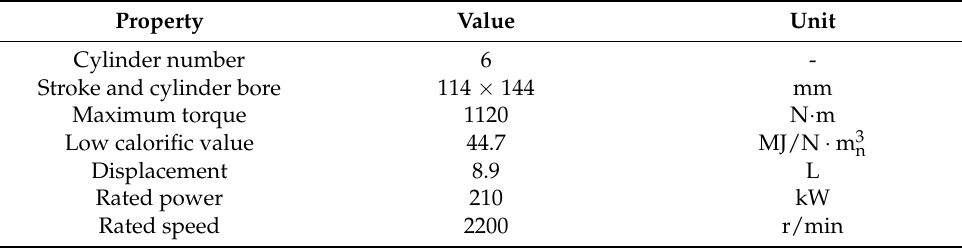
Table 3. Main parameters of